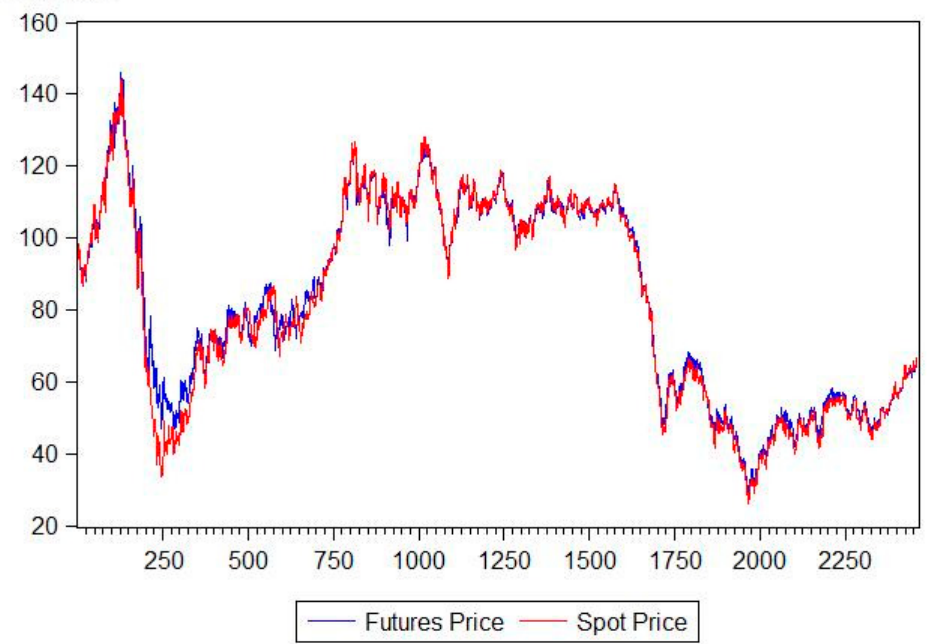
Figure 1. Trend chart of Brent crude oil futures price and spot price.